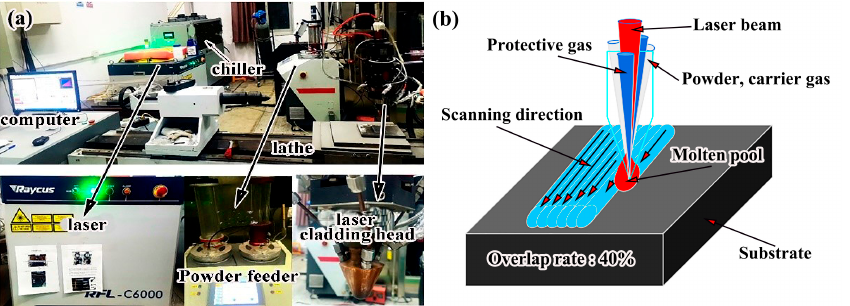
Figure 2. Laser cladding systems: ( a ) components of the experimental setup; ( b ) schematic of laser cladding process showing scanning direction. Table 3. Test factor level.